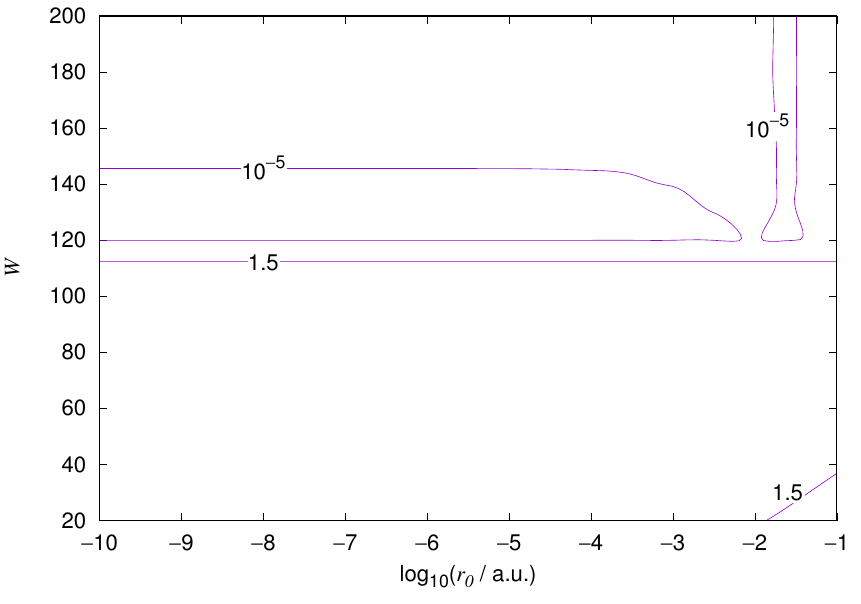
Figure 4. Relative error of the wavefunction value at the core radius for the hydrogen 2s orbital. Notations as in Figure